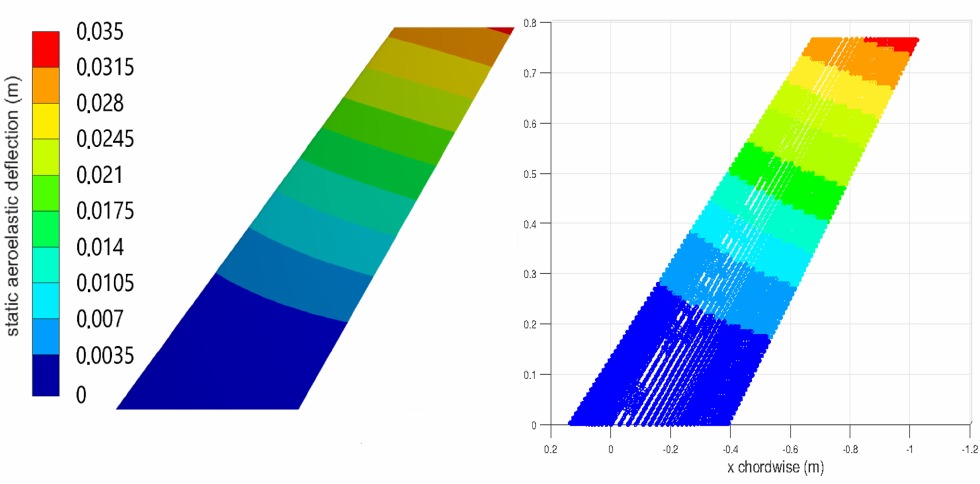
Figure 12. AGARD wing Case 2: static aeroelastic displacement, full solution ( left ) and ROM ( right